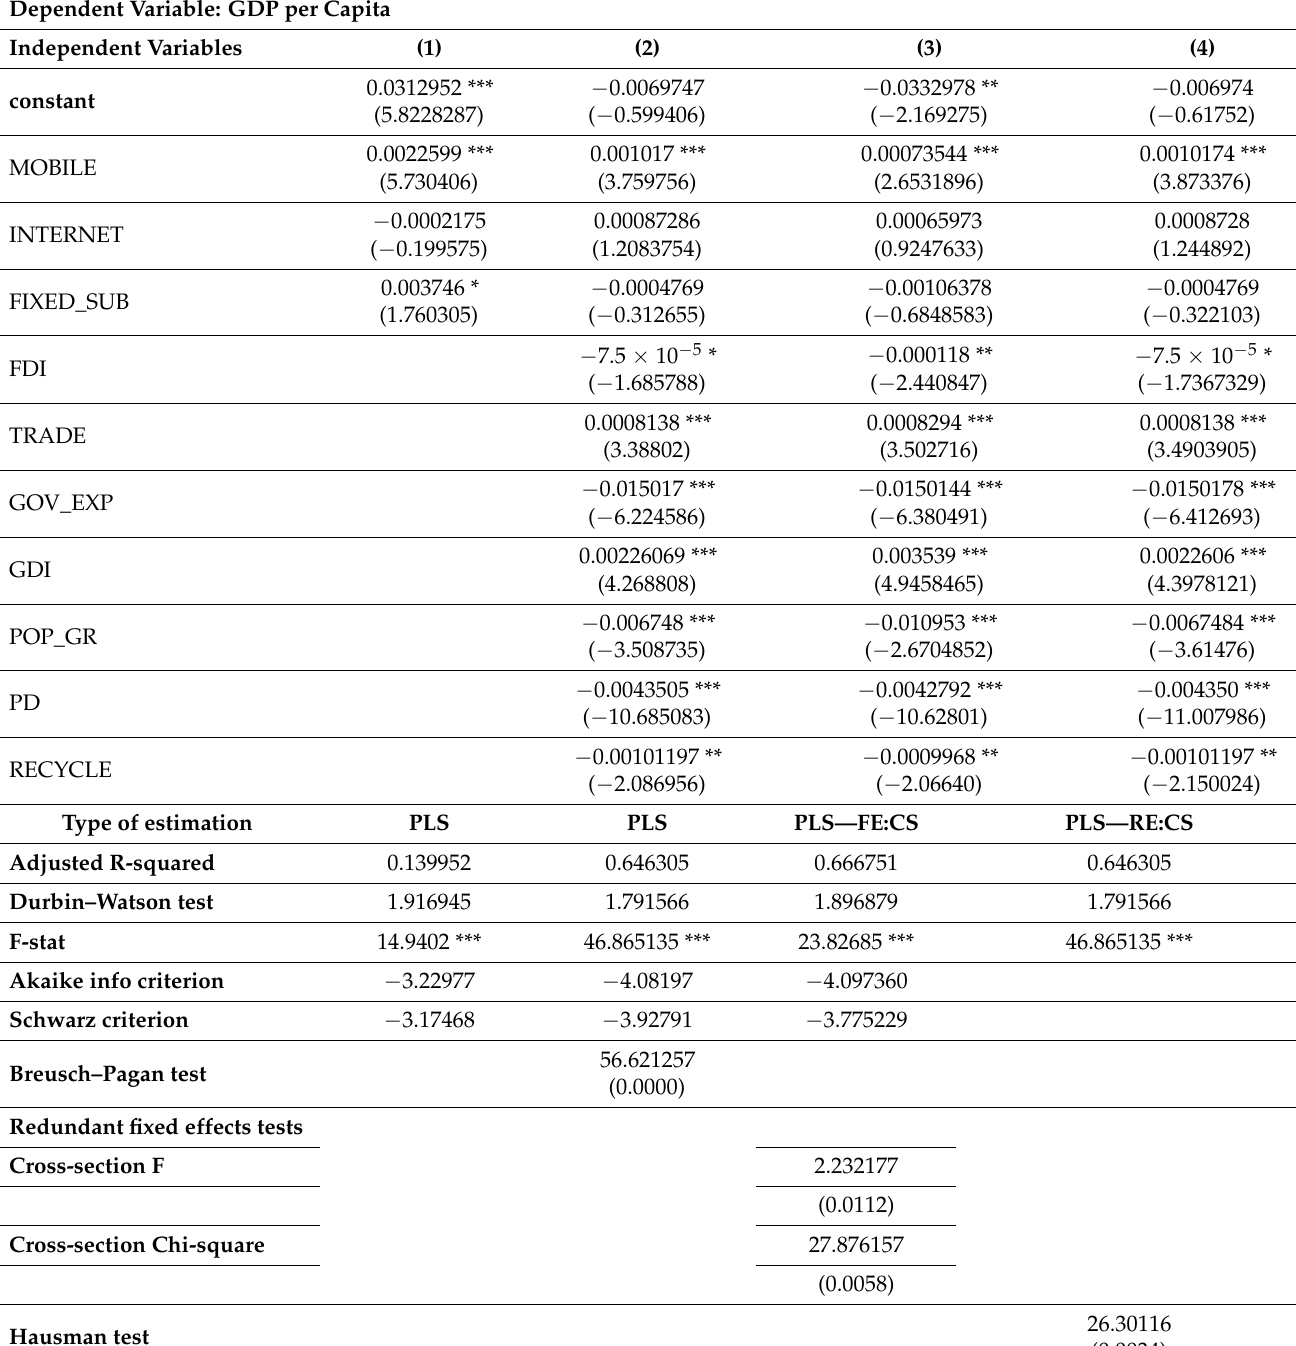
Table 8. Empirical results of panel regressions—EU-13